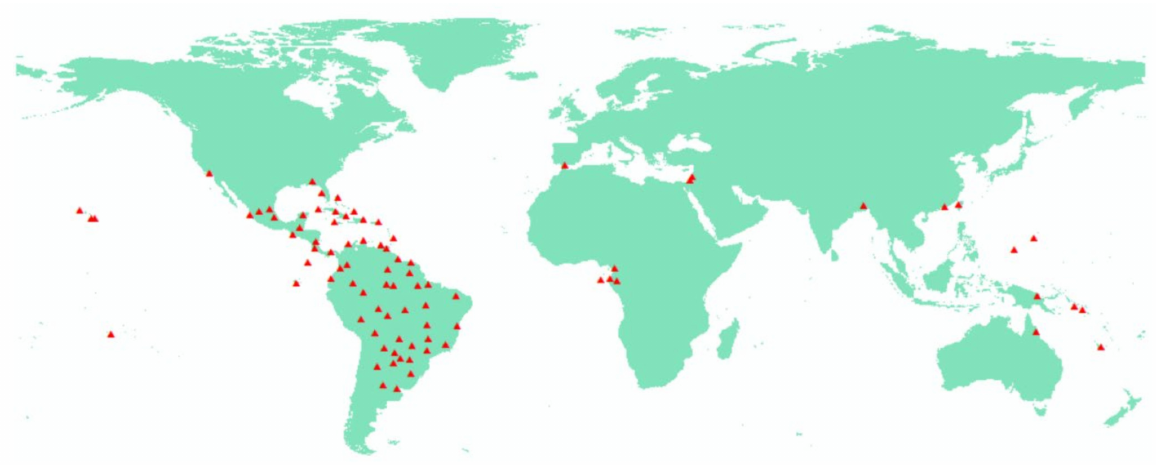
Figure 1. Species occurrence records on W. auropunctata . Notes: The red triangles indicate distribu- tion